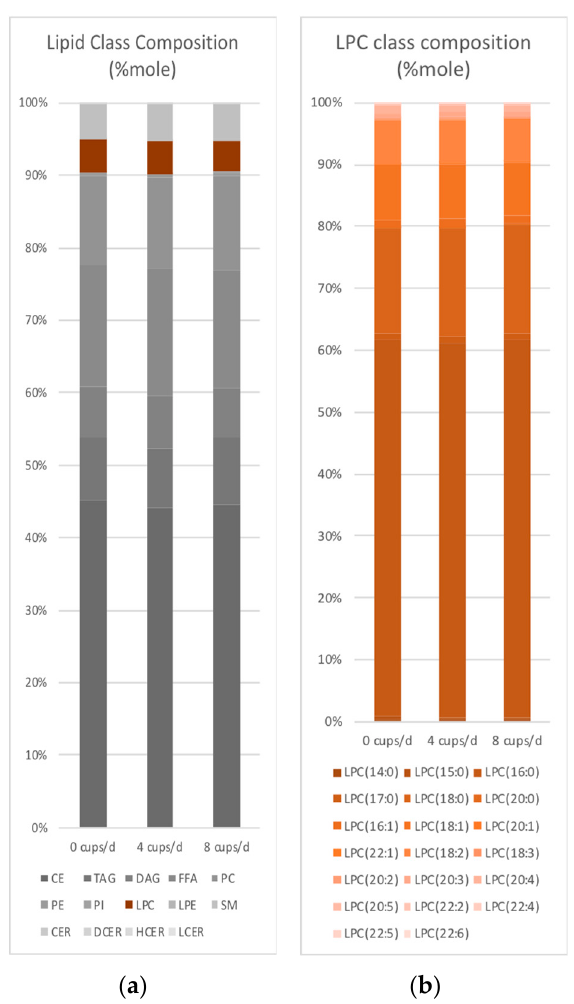
Figure 1. Lipid class ( a ) and LPC ( b ) composition response to coffee intake.